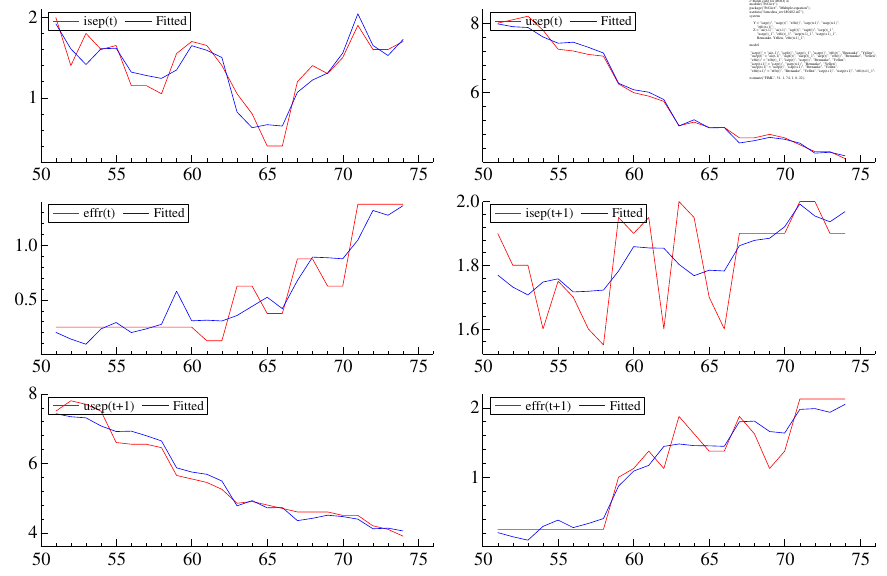
Figure 11. Actual versus Fitted FOMC